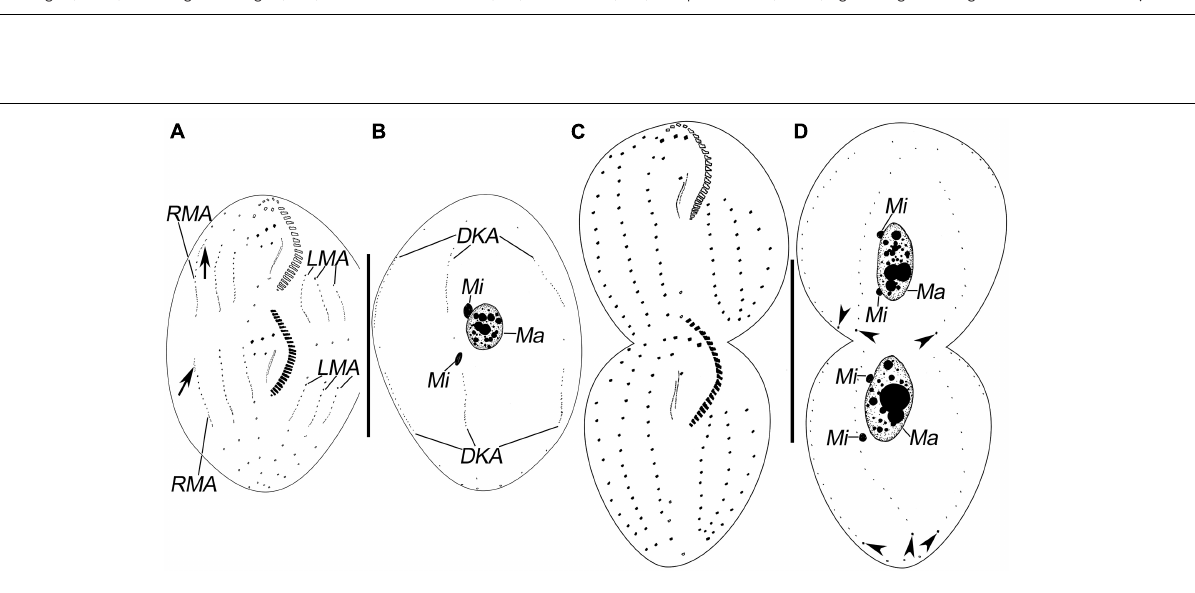
Frontiers in Microbiology |